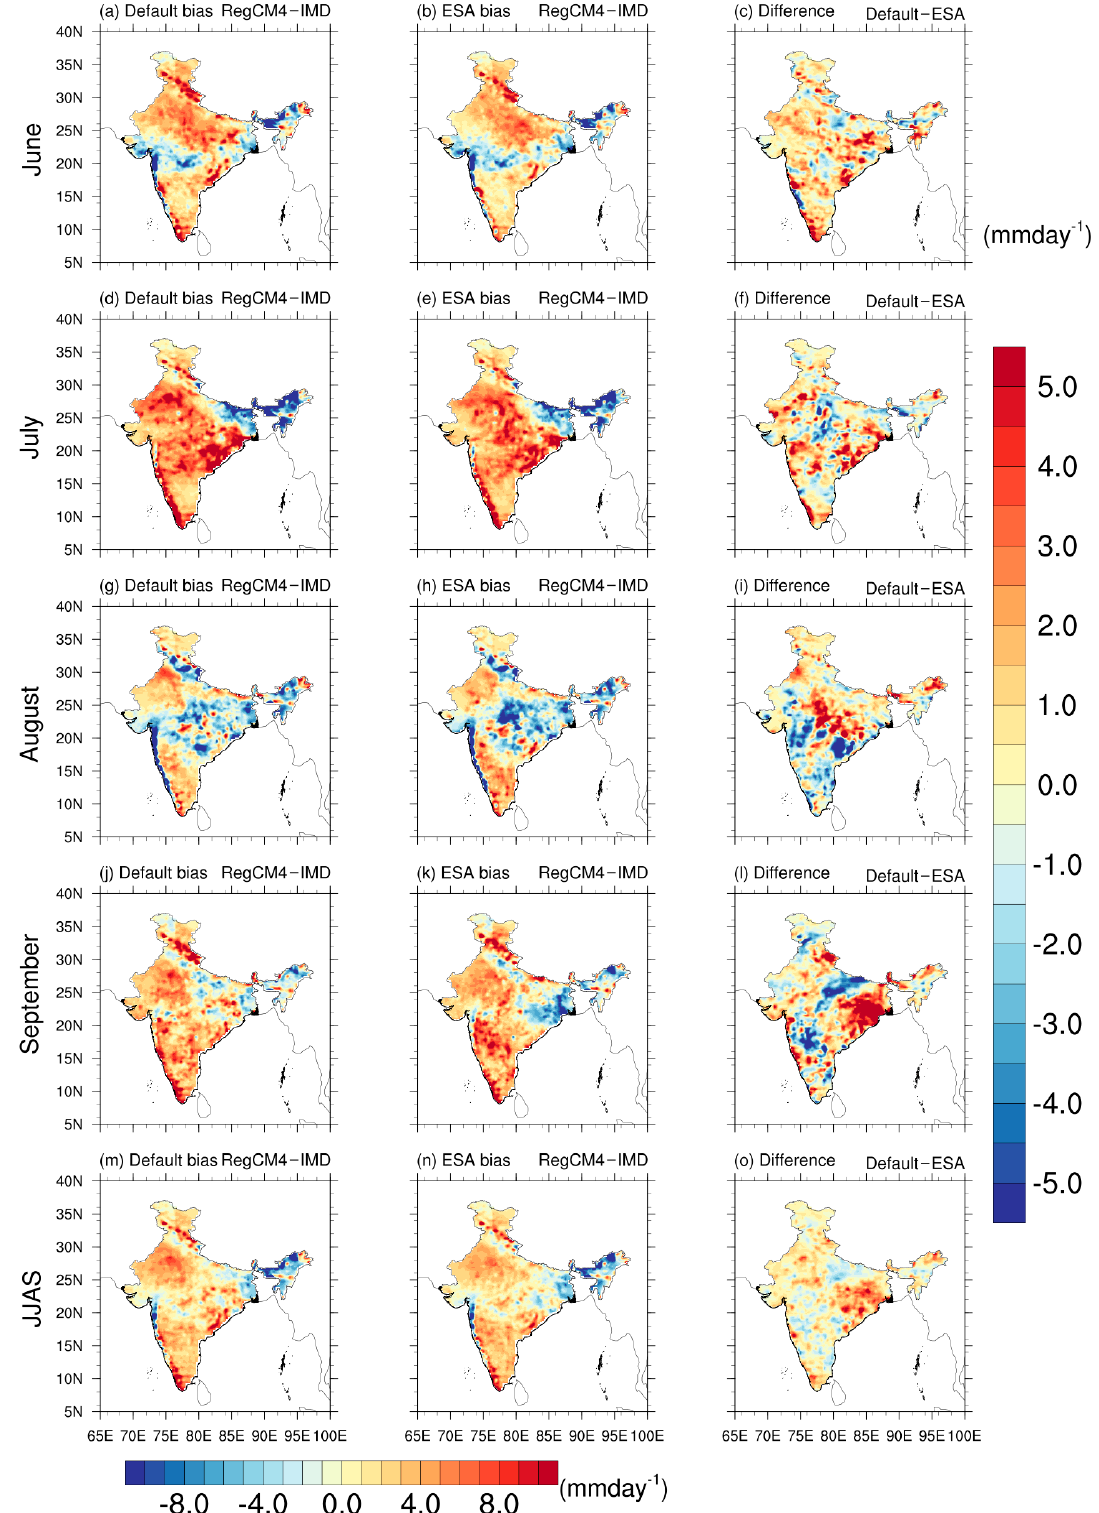
Figure 8. Rainfall bias (mmday − 1 ) at monthly and seasonal scales for the year 2002 from both the model configuration. IMD analysis is considered as ground truth. Rows correspond to ( a – c ) June, ( d – f ) July, ( g – i ) August, ( j – l ) September and ( m – o ) JJAS means. Columns represent the results from the default setup (1st column), ESA setup (2nd column) and their differences (3rd column).